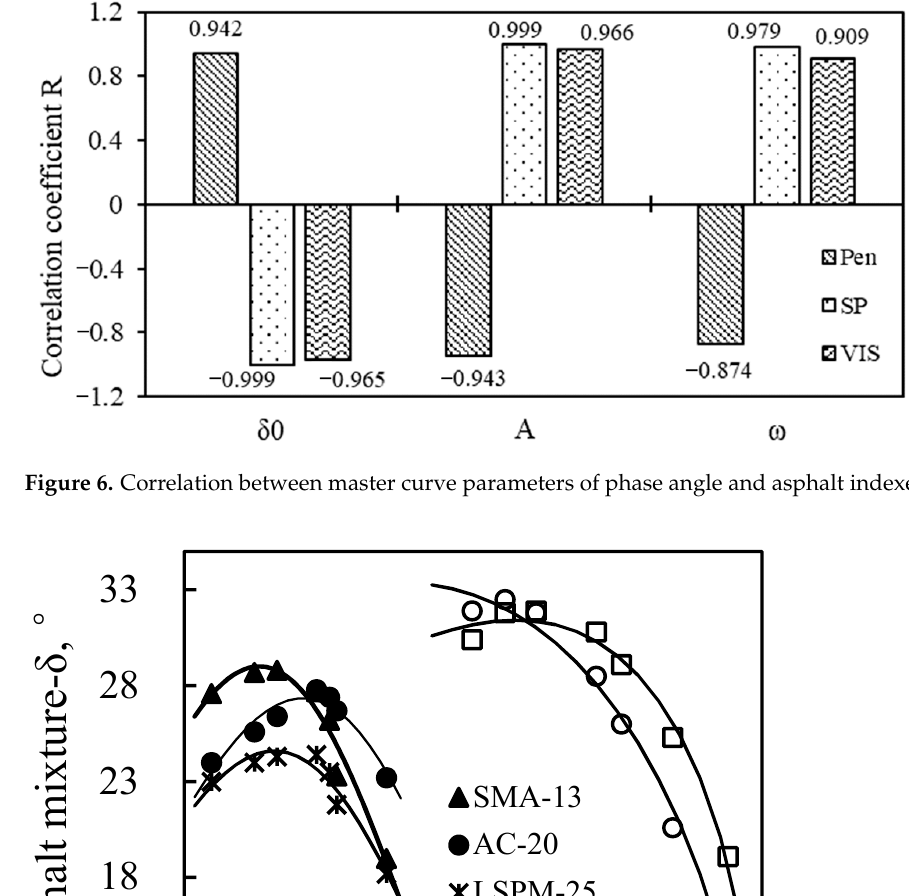
Figure 7. Phase angle relationship between asphalt and mixture.